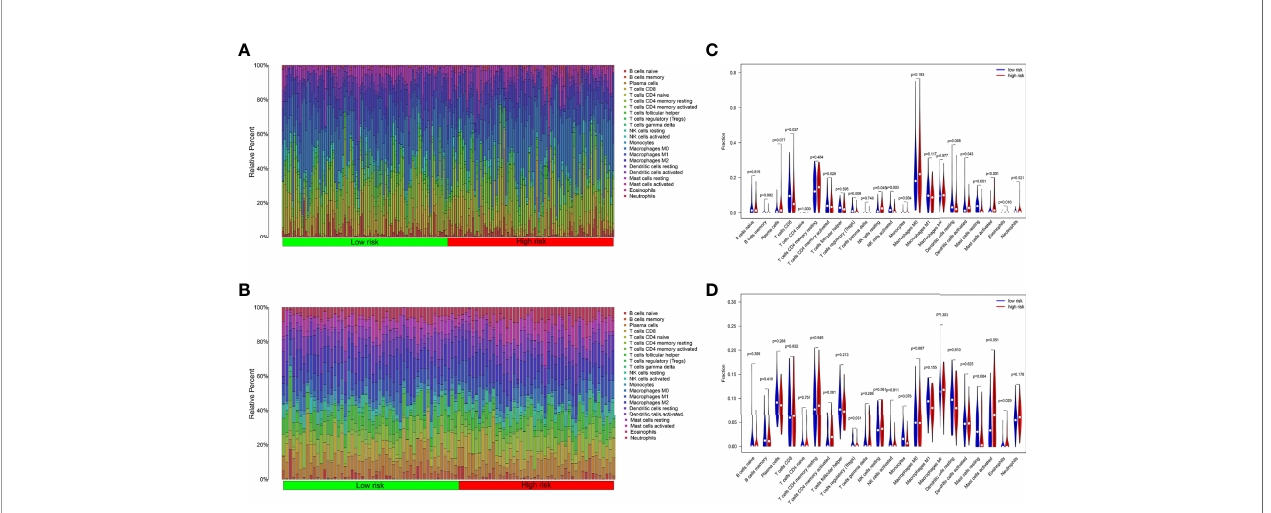
FIGURE 6 | Tumor immune cell in fi ltration analysis. (A) Ratio of 22 kinds of immune cells in fi ltrated in OSCC tumor samples from TCGA. (B) Ratio of 22 kinds of immune cells in fi ltrated in OSCC tumor samples from GEO. (C) The ratio of immune cells in the high-risk group is different from the low group in TCGA. (D) The ratio of immune cells in the high-risk group is different from the low group in GEO.